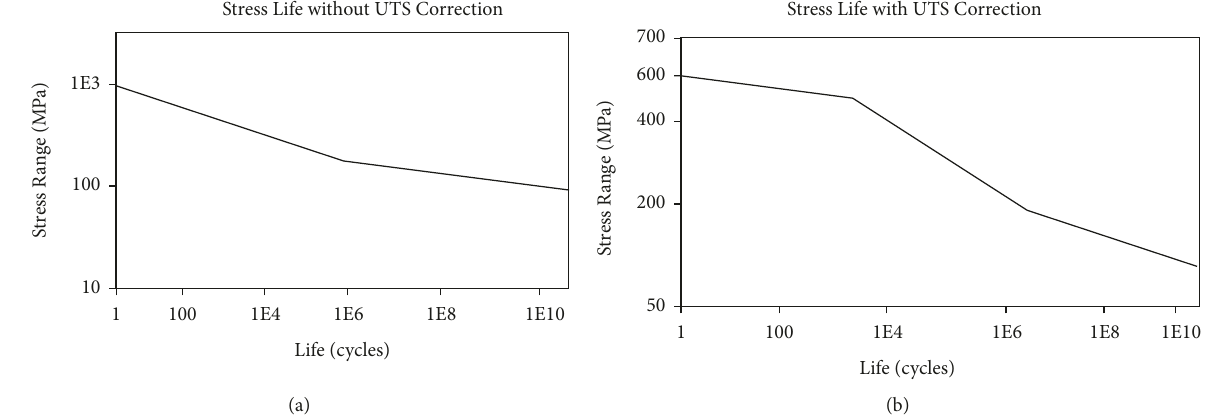
Figure 24: SN curve for PP-LGF30 material. (a) Static analysis of displacement cloud map; and (b) statics analysis of stress cloud